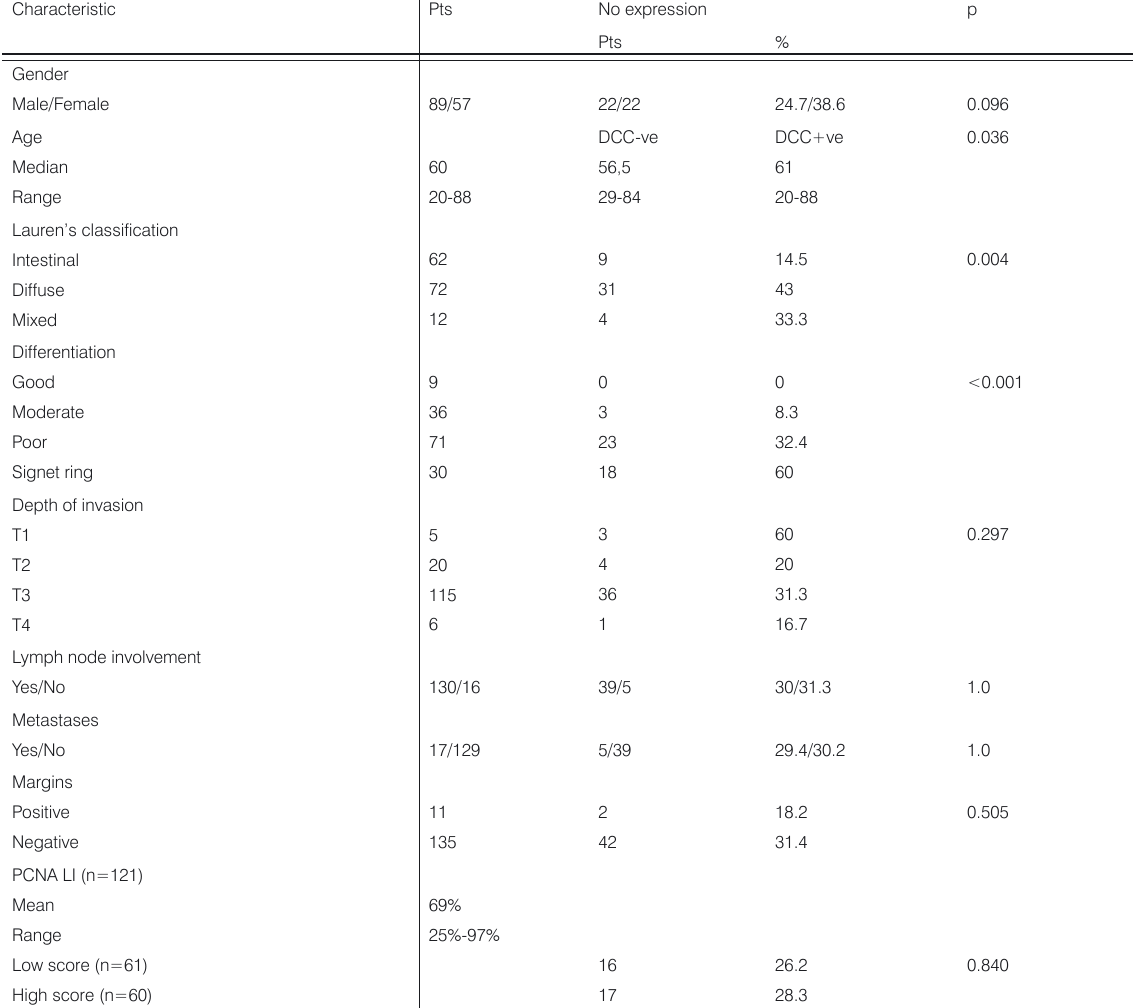
Table 1. Patients’ characteristics and correlation with DCC